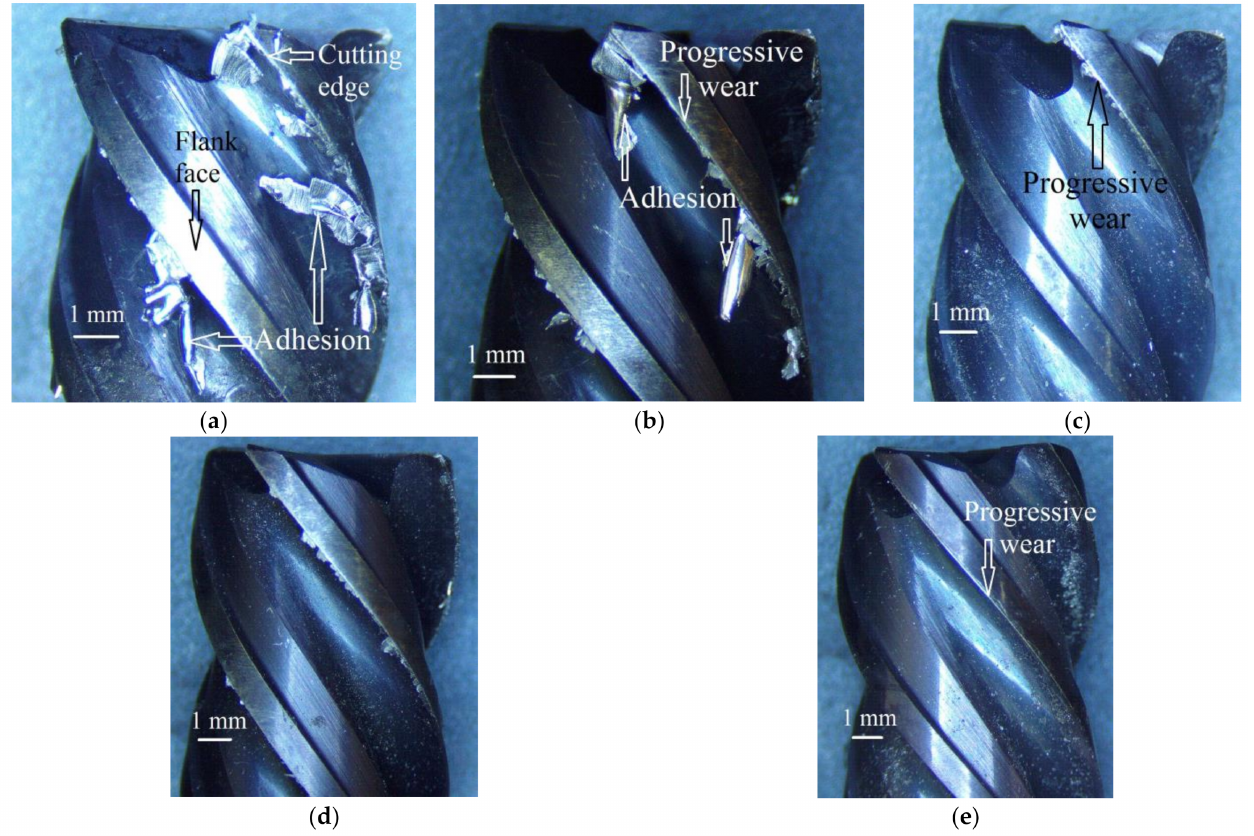
Figure 3. Micrographs of the milling cutters used in the following runs: ( a ) coolant = dry, V c = 150 m/min; ( b ) coolant = evaporative, flow rate = 0.2 kg/min, V c = 200 m/min; ( c ) coolant = evaporative, flow rate = 0.6 kg/min, V c = 200 m/min; ( d ) coolant = throttle, flow rate = 0.4 kg/min, V c = 200 m/min; and ( e ) coolant = throttle, flow rate = 0.6 kg/min, V c = 200